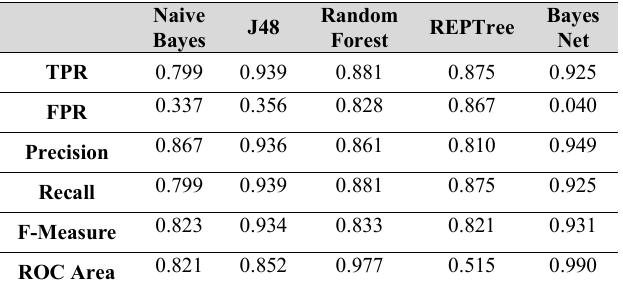
Table 3. Comparison of quality metrics of different classification algorithms